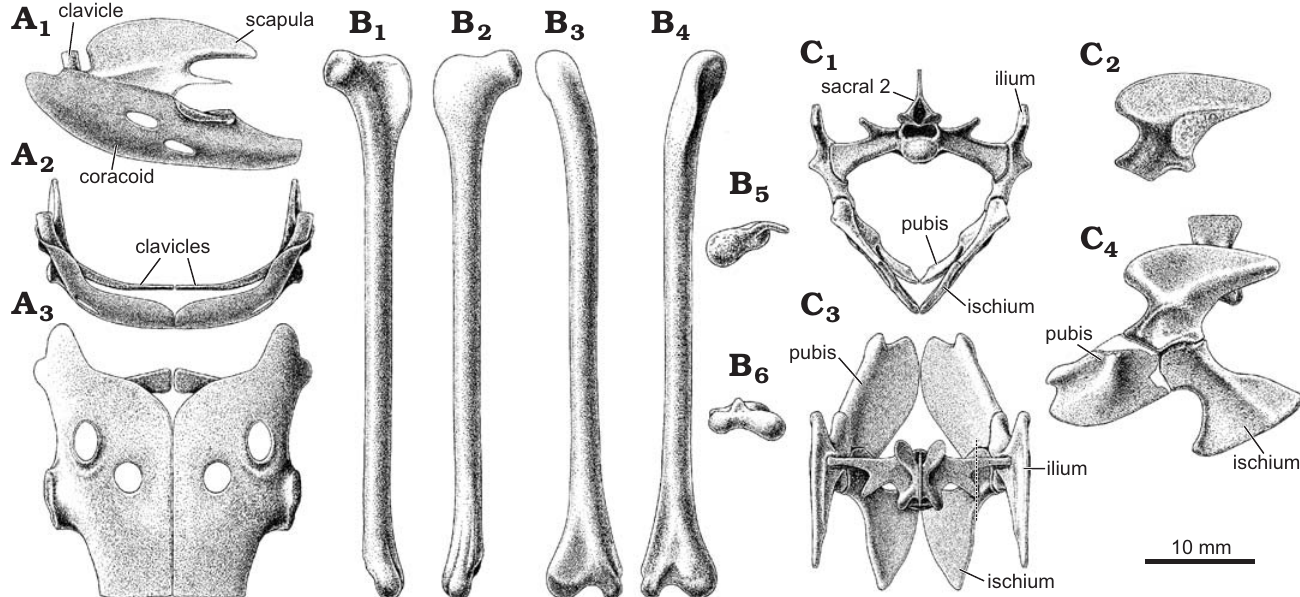
Fig. 11. Restoration of pectoral and pelvic girdle elements of long-necked reptile Ozimek volans gen. et sp. nov. A . Scapulocoracoid and clavicles in left lateral (A 1 ), anterior (A 2 ), and ventral (A 3 ) views, based on ZPAL AbIII/2512. B . Right humerus in proximal (B 1 ), medial (B 2 ), external (B 3 ), distal (B 4 ), anterior (B 5 ), and posterior (B 6 ) views, based on a juvenile ZPAL AbIII/2512. C . Pelvis with sacral 2 in posterior (C 1 ) and dorsal (C 3 ) views, ilium in medial view (C 2 ), pelvis in left lateral view (C 4 ), based on ZPAL